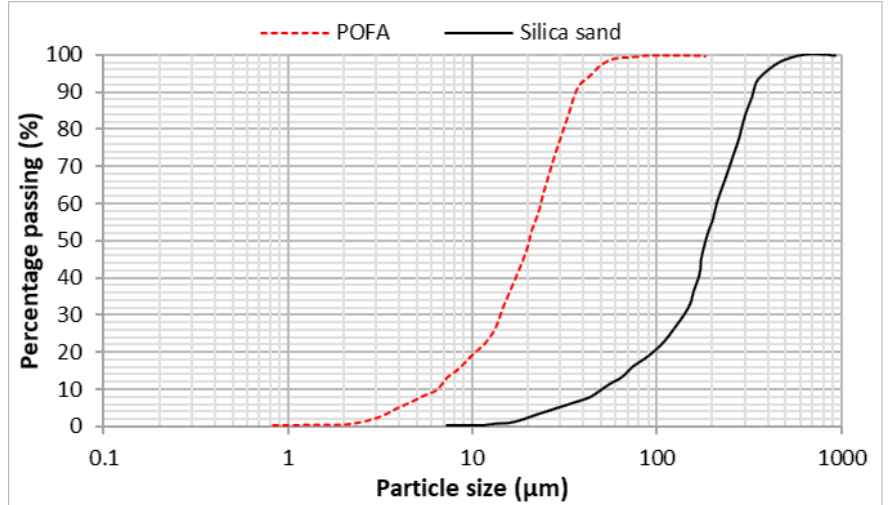
Figure 2. Particle size distribution for silica sand and POFA.